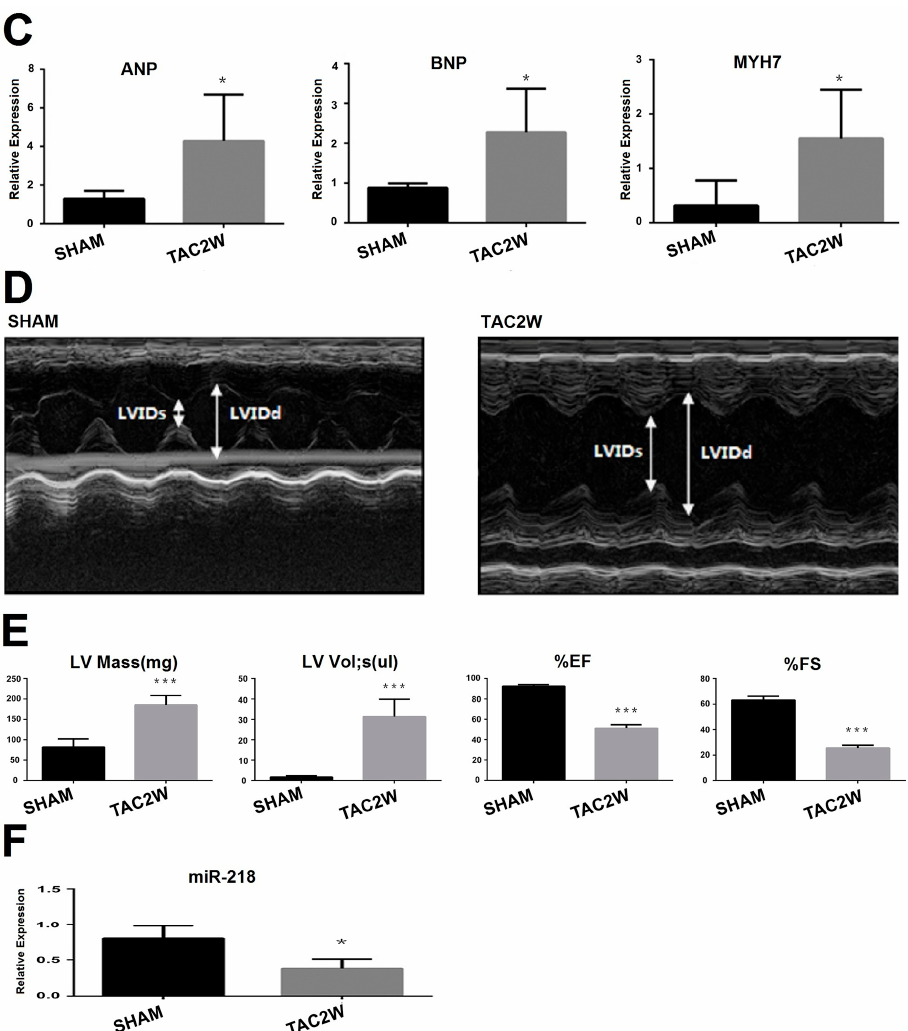
Figure 2. Downregulation of miR-218 in the heart of the two-week TAC (TAC2W) mouse model. ( A ) the change of gross morphology for the heart of the TAC model (Scale bar: 1 mm); ( B ) the change of weight-to-body ratio for the hearts of TAC-models ( n = 13) and sham mice ( n = 5); ( C ) the relative mRNA levels of ANP , BNP and MYH7 in the hearts of TAC models ( n = 13) and sham mice ( n = 5); ( D , E ) the echocardiography results in two-week TAC models and the sham group ( n = 3); and ( F ) the relative levels of miR-218 in two-week TAC-models (* p < 0.05; *** p < 0.001).